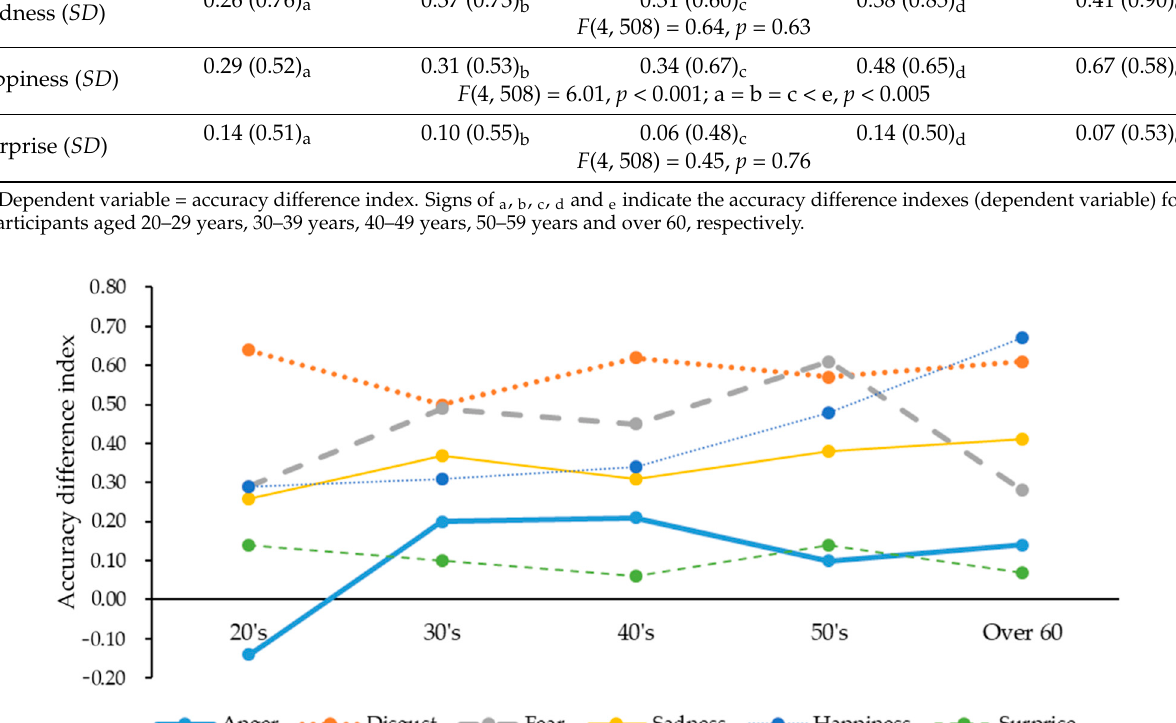
Table 4. Comparisons of participants’ accuracies to recognize senders’ facially expressed emotions between no mask and mask conditions for participant nationality groups.